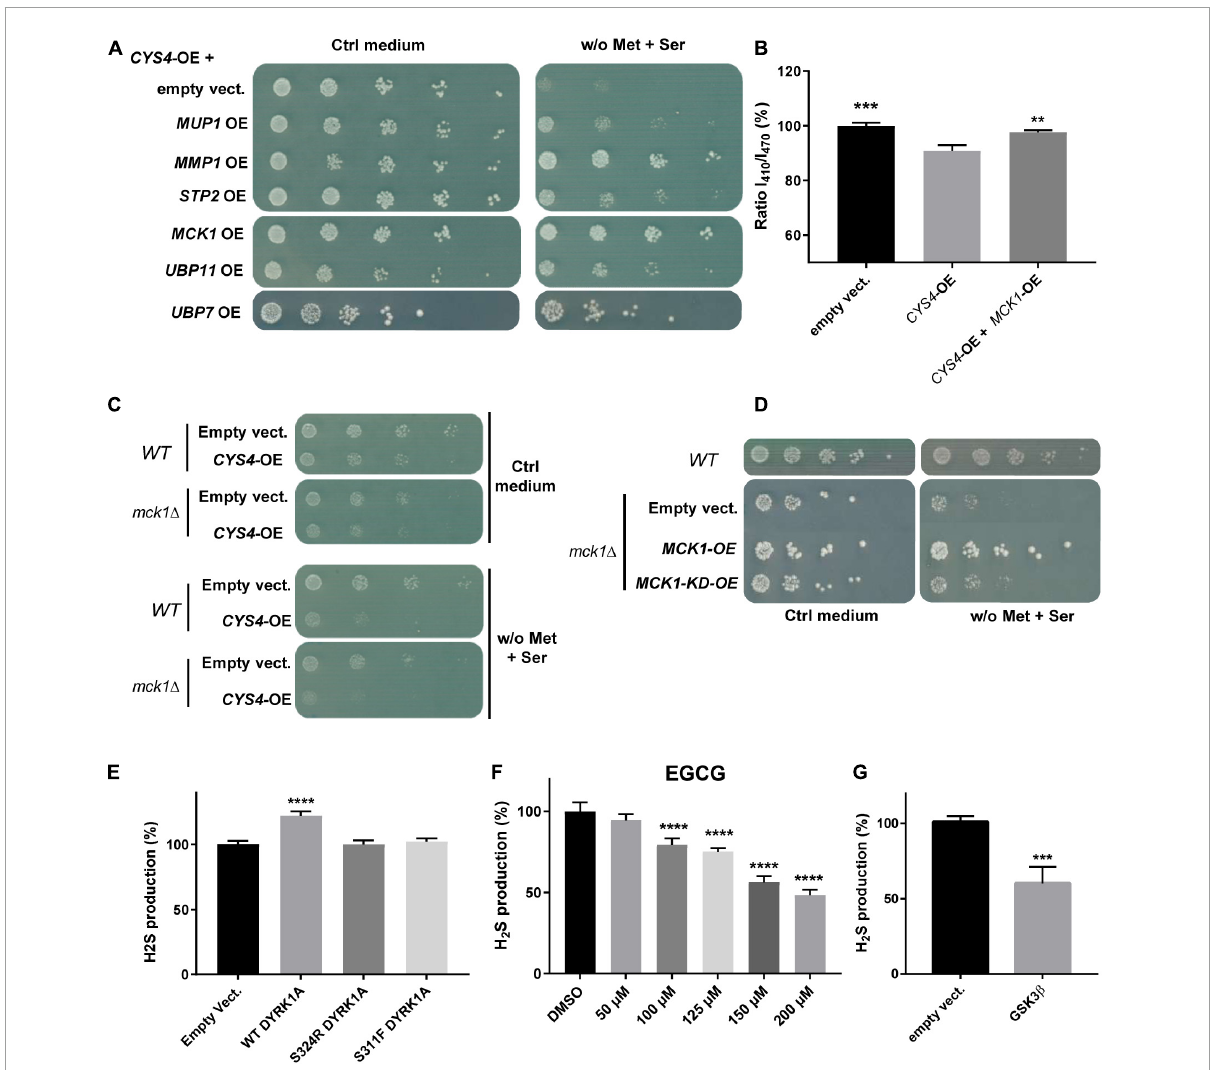
FIGURE2 A genetic screening identified MCK1 as a genetic repressor of CYS4 -OE induced phenotypes. (A,B) MCK1 -OE rescues the consequences of CYS4 -OE. (A) Genes that were the most effective in rescuing the methionine auxotrophy induced by CYS4 -OE include genes related to amino acid import ( MUP1 , MMP2 , STP2 ), a kinase ( MCK1 ), and two genes encoding deubiquitinating enzymes ( UBP7 and UBP11 ). (B) MCK1 -OE restores normal cytosolic acidification of CYS4 -OE cells. Comparison of each condition with CYS4 -OE, one-way ANOVA with Dunnett’s post-hoc